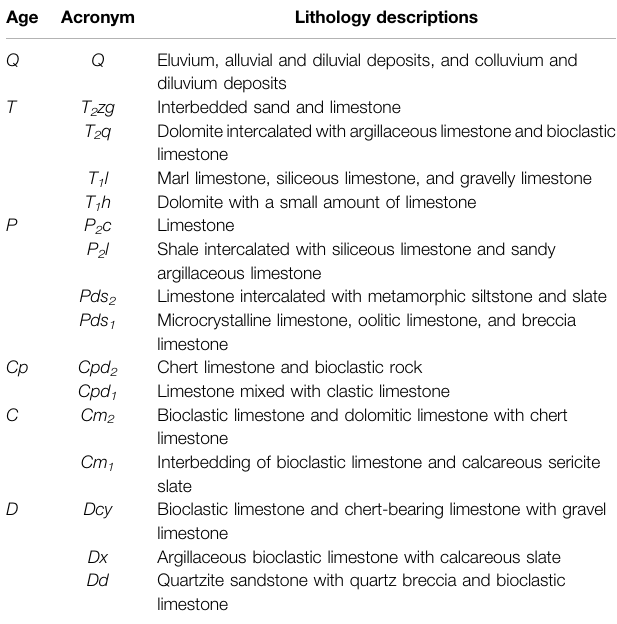
TABLE 1 | Description of geologic units and lithology of the study area.